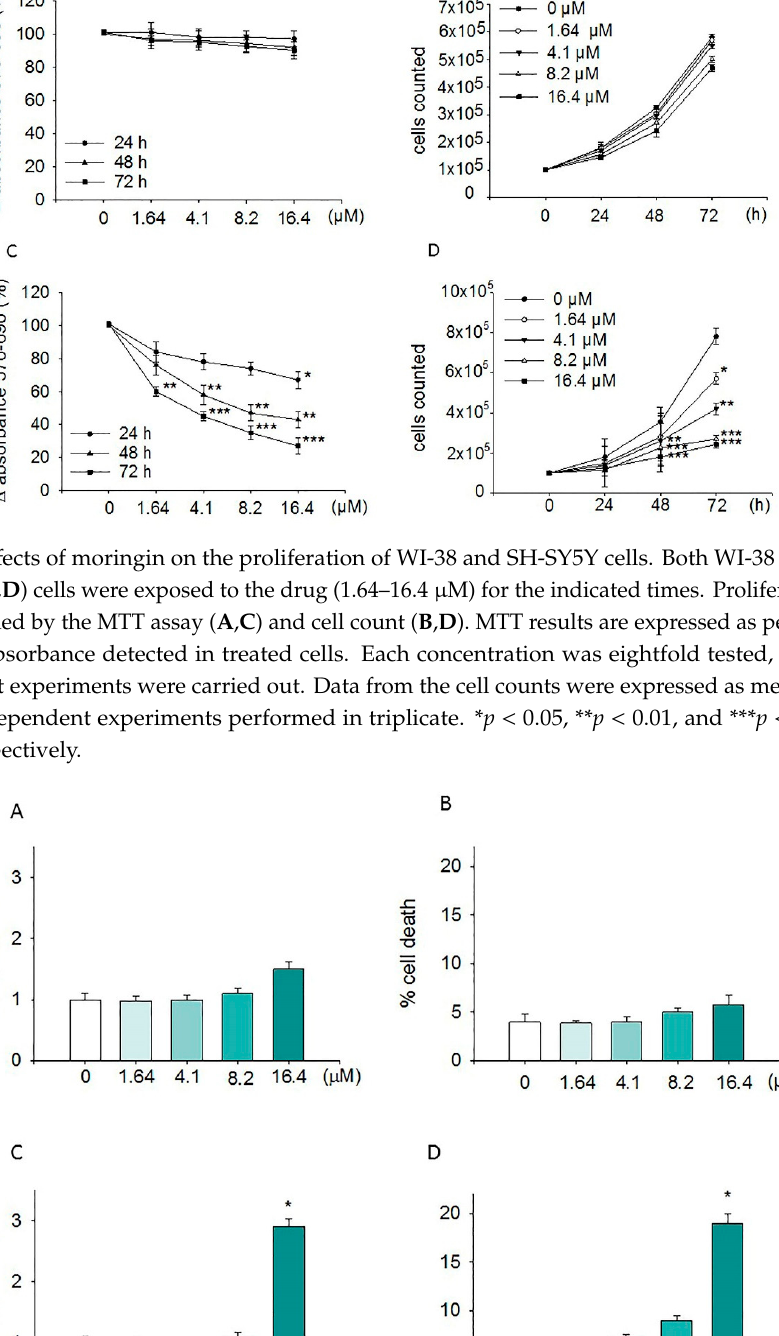
Figure 3. Morphological analyses of the SH-SY5Y cells treated with moringin. Cell morphology was monitored after treatment with different concentrations (1.64–16.4 µM) of moringin for 24 h. The morphological changes were observed under an inverted microscope (200×).